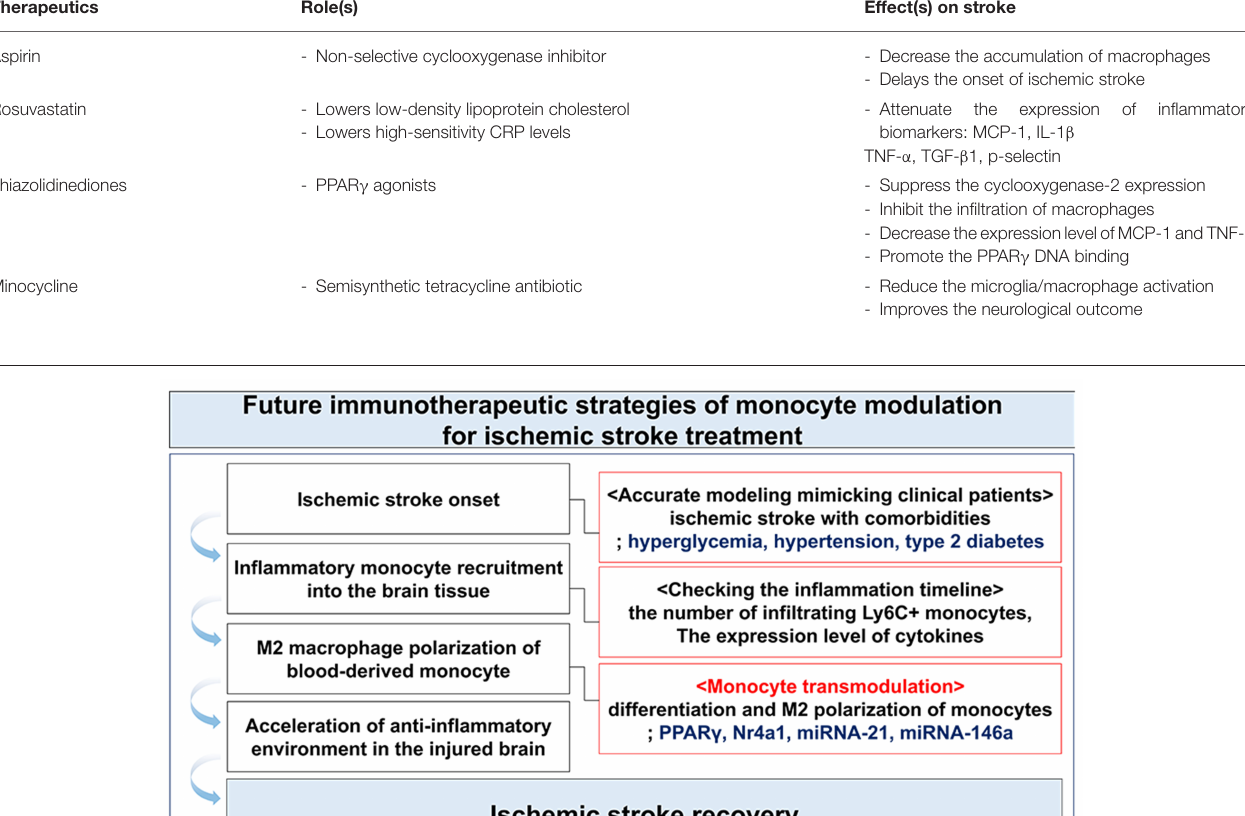
TABLE 3 | Current ischemic stroke therapeutics targeting anti-inflammation. Therapeutics